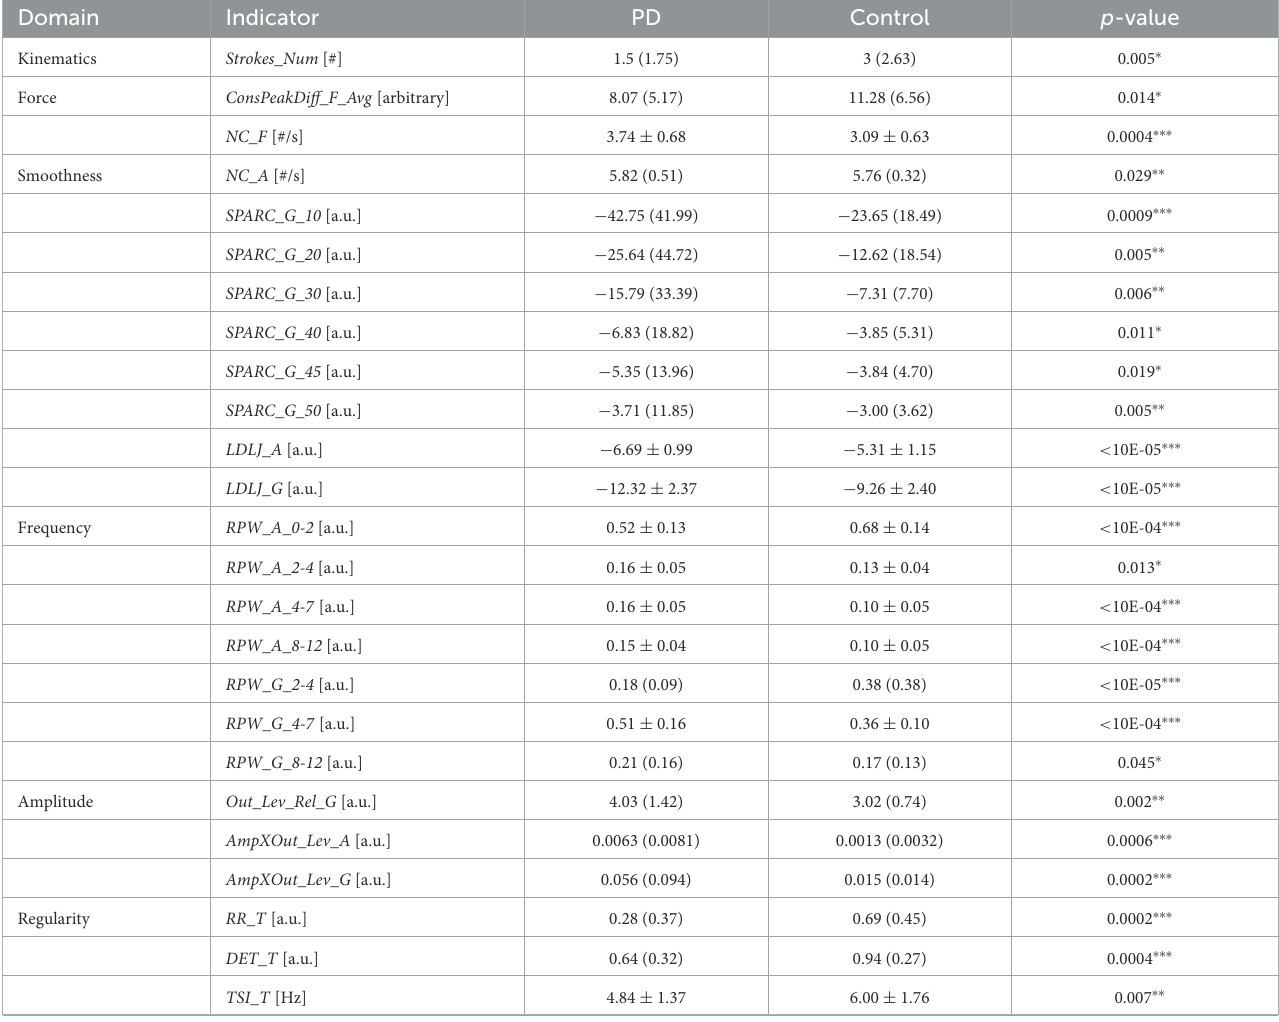
TABLE 1 Statistically significant results of the between-group